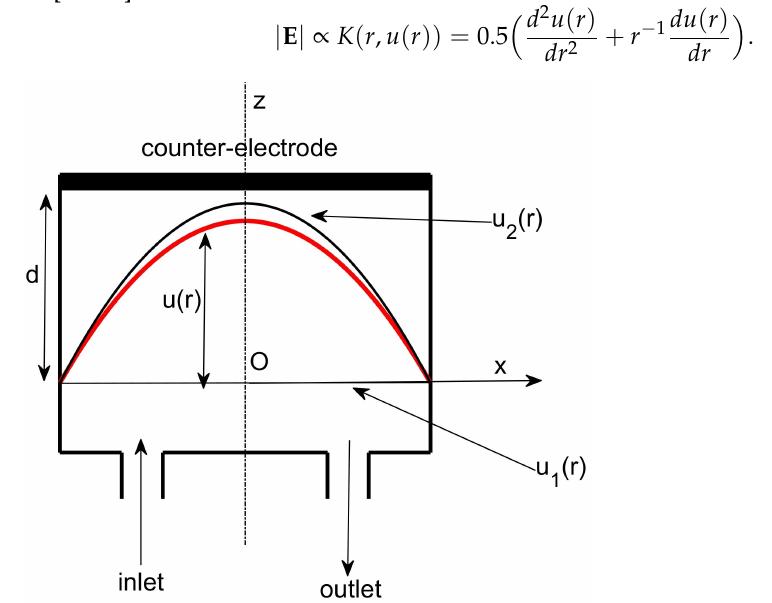
Figure 1. The micropump: u ( r ) vs. r : visualization of u ( r ) , 1 − u ( r ) , d ∗ and the upper and lower solutions u 1 ( r ) and u 2 ( r )